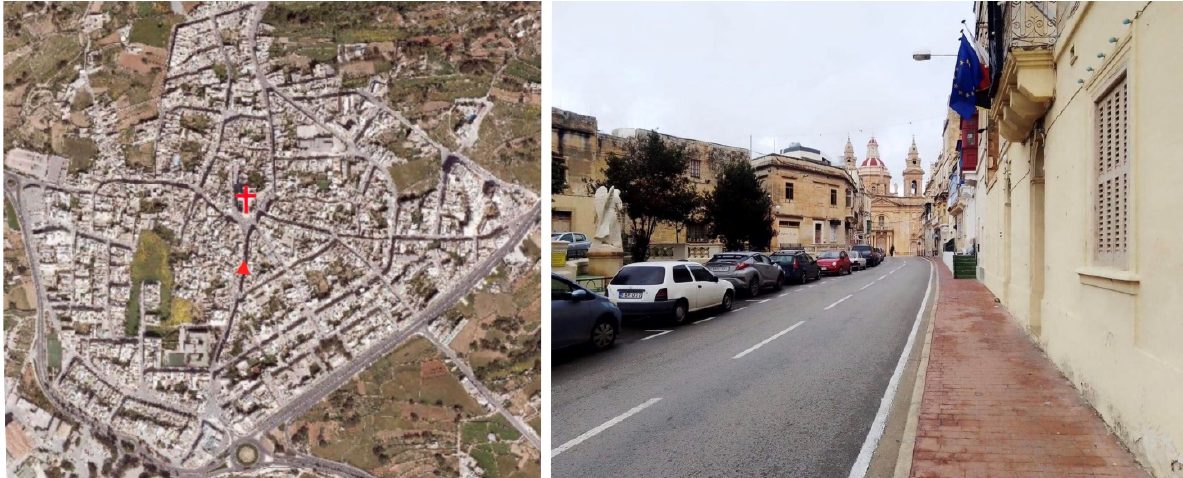
Figure 3. Luqa (online version is in colour): orthophoto of the urban area (left) (© Planning Authority, Malta), the position of photo and church shown in Figure 3 right, is marked by ▲ and + respectively; the main street , named after the patron saint of the town,